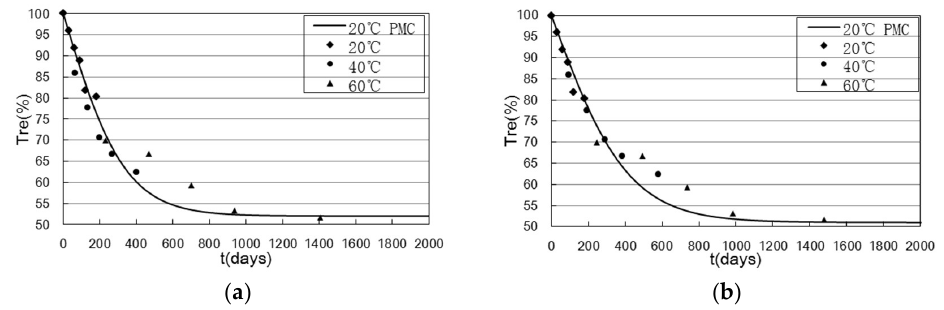
Figure 26. Estimated data and test data at 20 °C, with the curve for 20 °C by the fourth model: ( a ) G1; ( b ) G2.